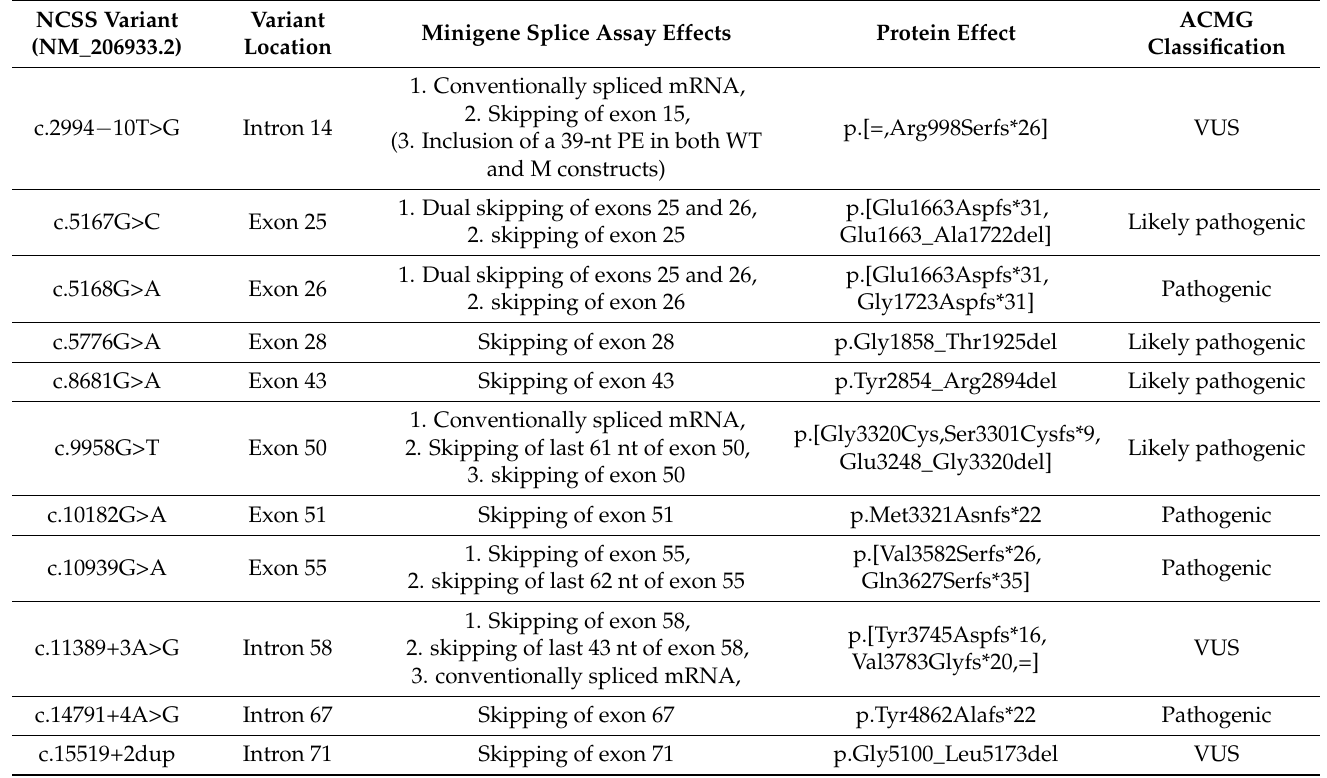
Table 2. Protein effects of the splicing aberrations caused by the 11 selected